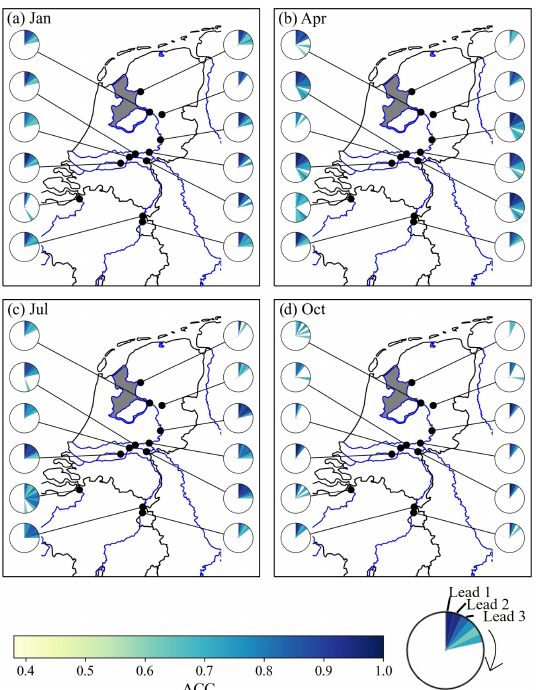
Figure B3. Anomaly correlation coefficient (ACC; weekly) for (a) January, (b) April, (c) July, and (d) October for surface water level hindcasts (fresh surface water levels such as rivers, streams, and lakes). Simulation results are based on the RF model showing the results for different stations (limited selection for visual purposes) in the national monitoring network. Only the major river networks are shown, and smaller streams or infrastructures are not highlighted (a station along the coast is placed at a sluice along a stream). Maps were created using the Python package Cartopy (Elson et al., 2022), which uses basemap data made with Natural Earth and © OpenStreetMap contributors 2022. Distributed under the Open Data Commons Open Database License (ODbL)